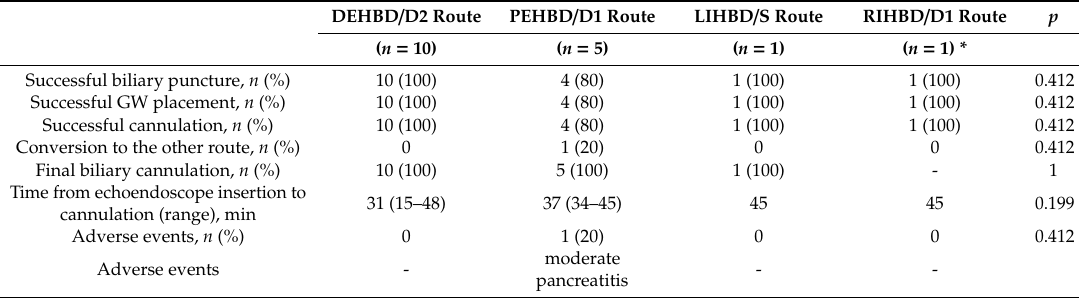
Table 4. Outcomes of